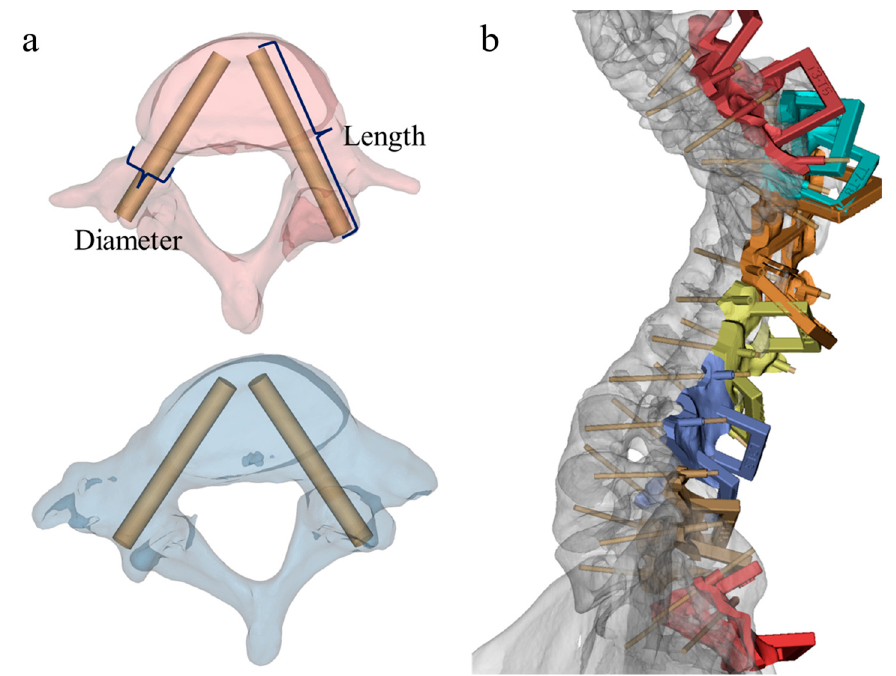
Figure 1. Design of screw guidance templates. ( a ) Design of screw insertion trajectory and the measurement of trajectory length and diameter; ( b ) design of screw trajectory and guidance templates.